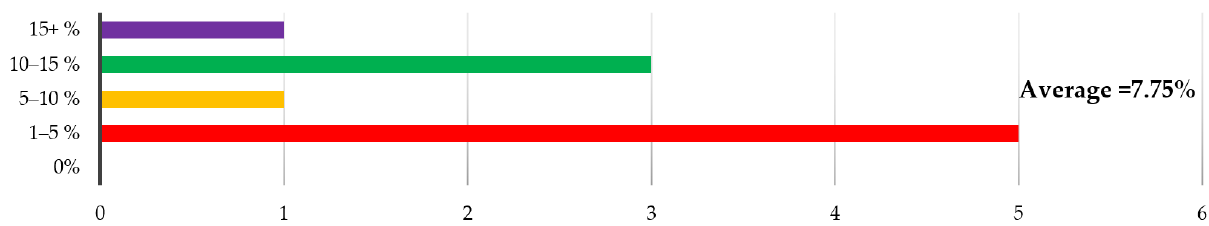
Figure 11. Responses to the question: “How much time did your design team (in the role of lead-appointed party) spend on BIM management and coordination activities? E.g., if the whole project was processed for a total of about 5000 h, and 250 h were allocated for BIM coordination, then 250/5000 = 5%”.